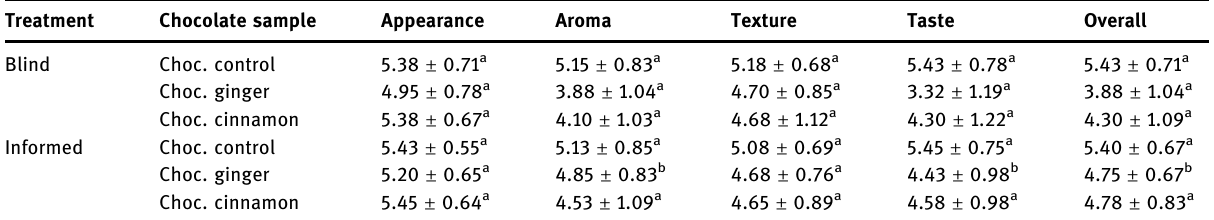
Table 3: The e ff ect of product information on hedonic response of chocolate bar formulated with ginger and cinnamon Treatment Chocolate